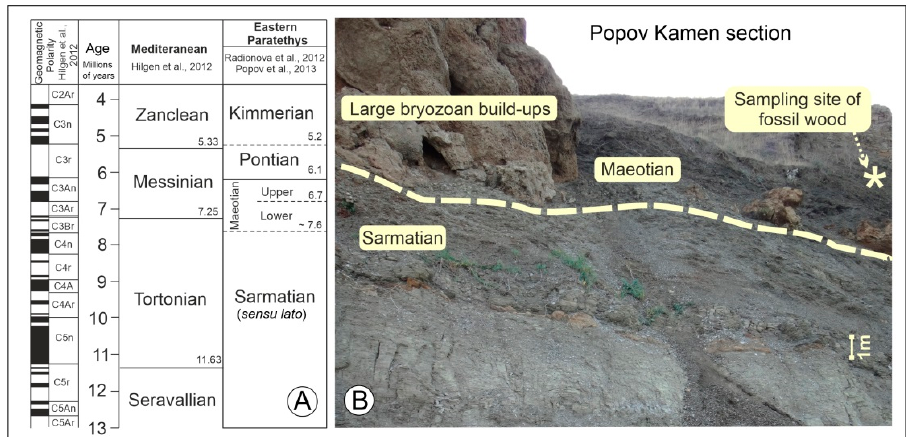
Figure 4. Geological setting of the mummified wood’s locality. ( A ) The time scale for Mediterranean and Eastern Paratethys (Black Sea). The ages of boundaries between the stages are indicated (millions of years). ( B ) The location of fossil woods; the boundary between the Sarmatian and Maeotian sediments was marked by yellow hashed line [50–52,54,55].